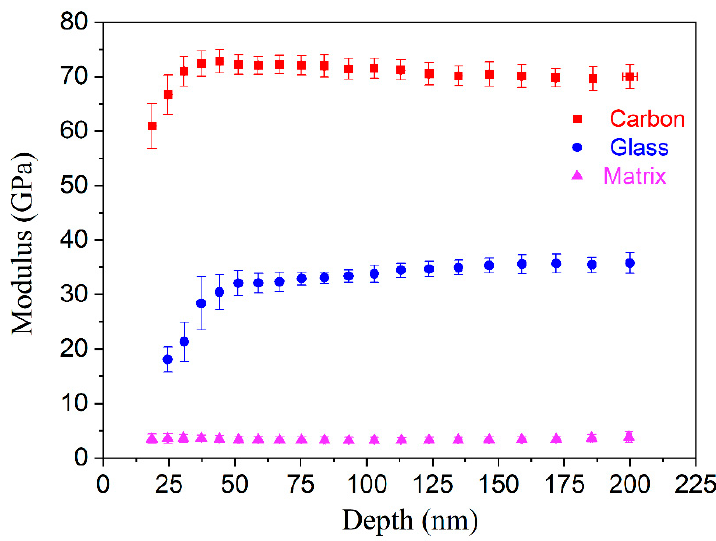
Figure 3. Modulus–depth curves for the three different phases.